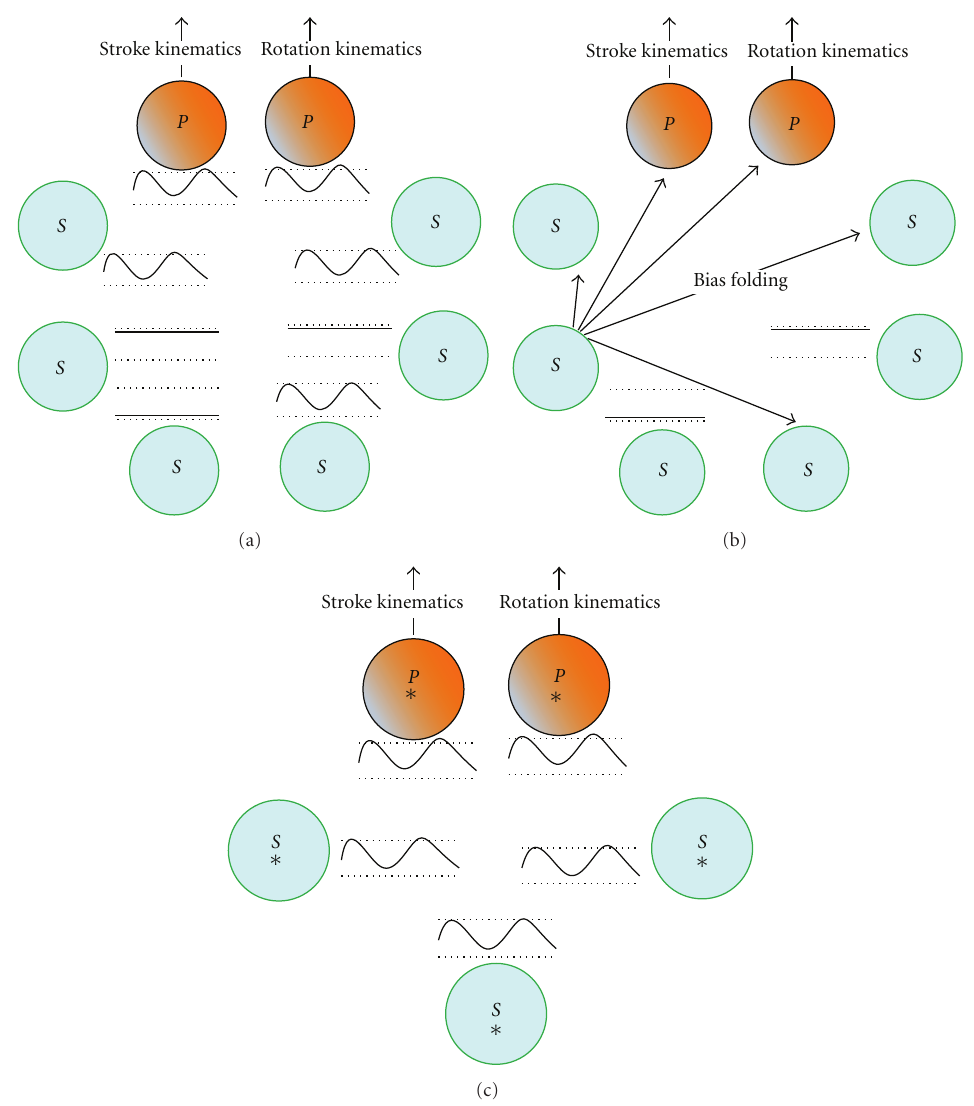
Figure 8: A pictorial representation of the “dynamics-deprived neuron elimination” process. The primary neurons are labeled as “ P ” and subsidiary neurons are labeled as “ S ”. A three step process is adopted here, starting with eliminating the neurons with saturated dynamics in them as shown in (a), followed by folding the saturated output of the eliminated neurons as bias into the survival neurons as shown in (b). The final step shown in (c) is to verify the qualitative match of the dynamics produced by the bias modified (labeled with “ ∗ ”) individual neurons to their counterparts in the original